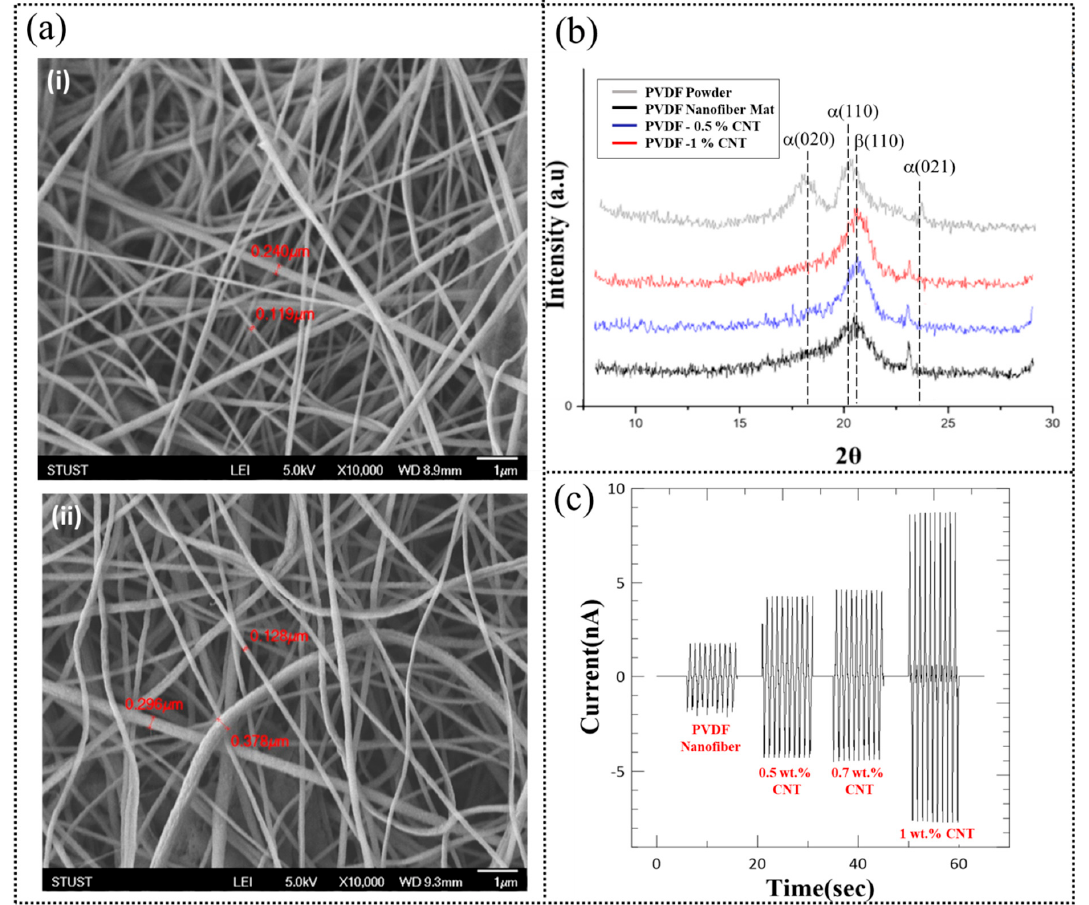
Figure 4. ( a ) FE-SEM images of (i) pure PVDF nanofibers and (ii) after doping with 1 wt. % MWCNT. ( b ) XRD spectra of PVDF powder and pure and MWCNT doped PVDF nanofiber mats obtained after centrifugal electrospinning. ( c ) Triboelectric current generation for pure and MWCNT doped PVDF